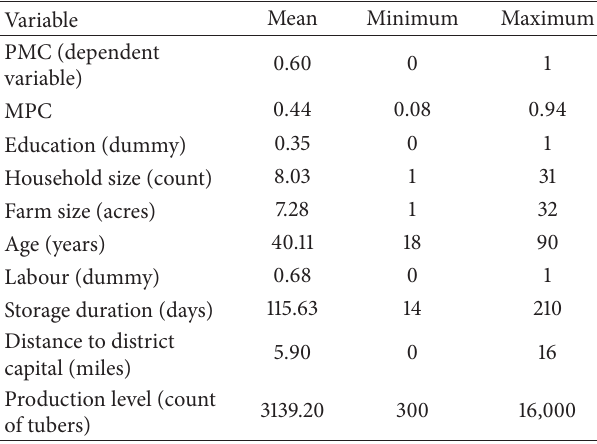
Table 3: Descriptive statistics of variables used in the fractional regression model.